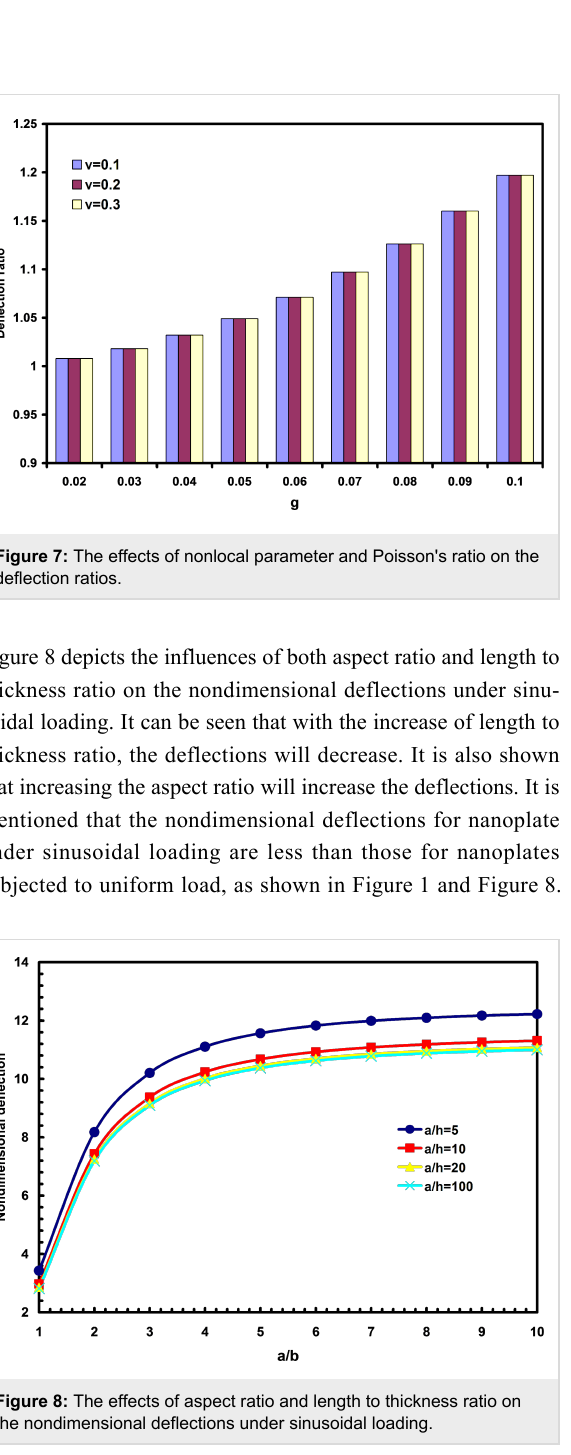
Figure 8: The effects of aspect ratio and length to thickness ratio on the nondimensional deflections under sinusoidal